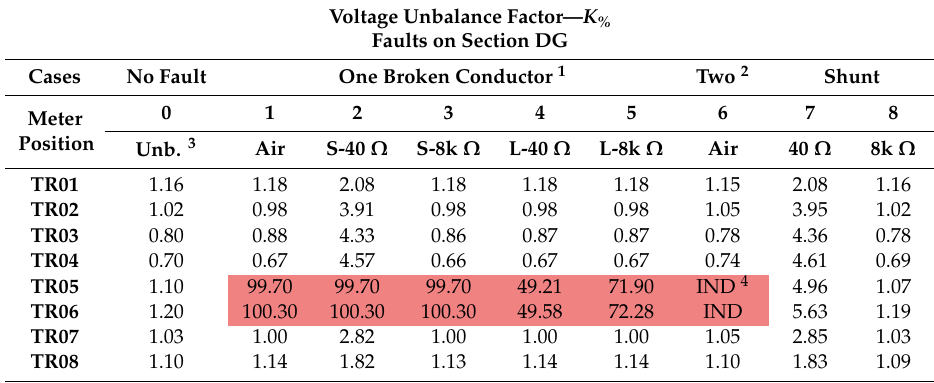
Table 5. Faults on section DG—voltage unbalance (results of K % for normal and fault condition).